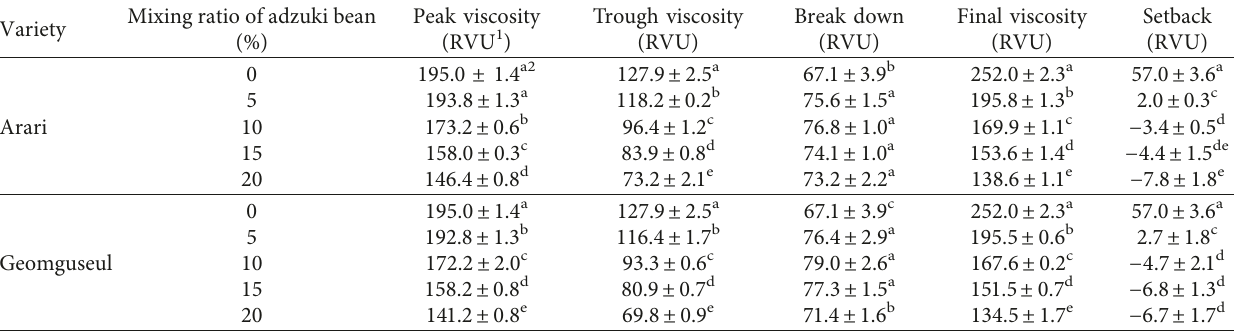
Table 1: Pasting characteristics with different mixing ratio of adzuki bean.